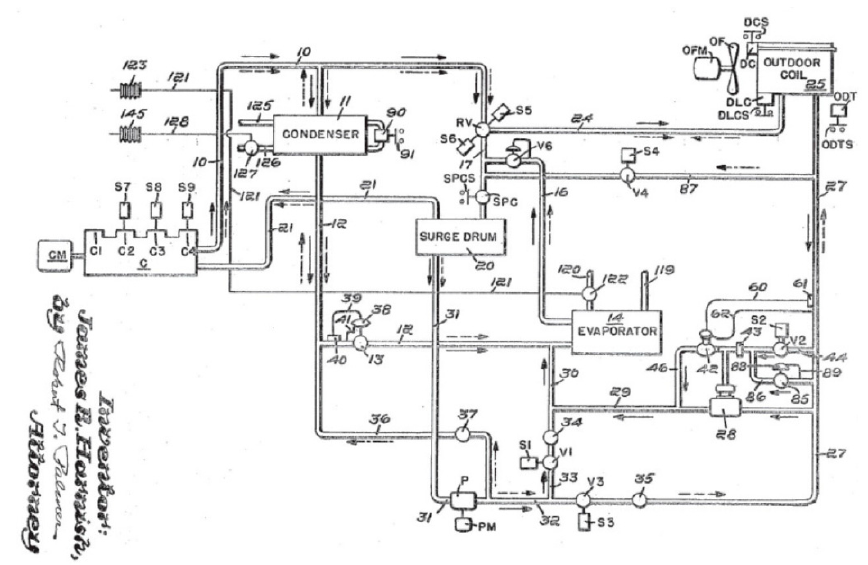
Figure 17. Schematic diagram of the patent of Westinghouse Electric Corporation